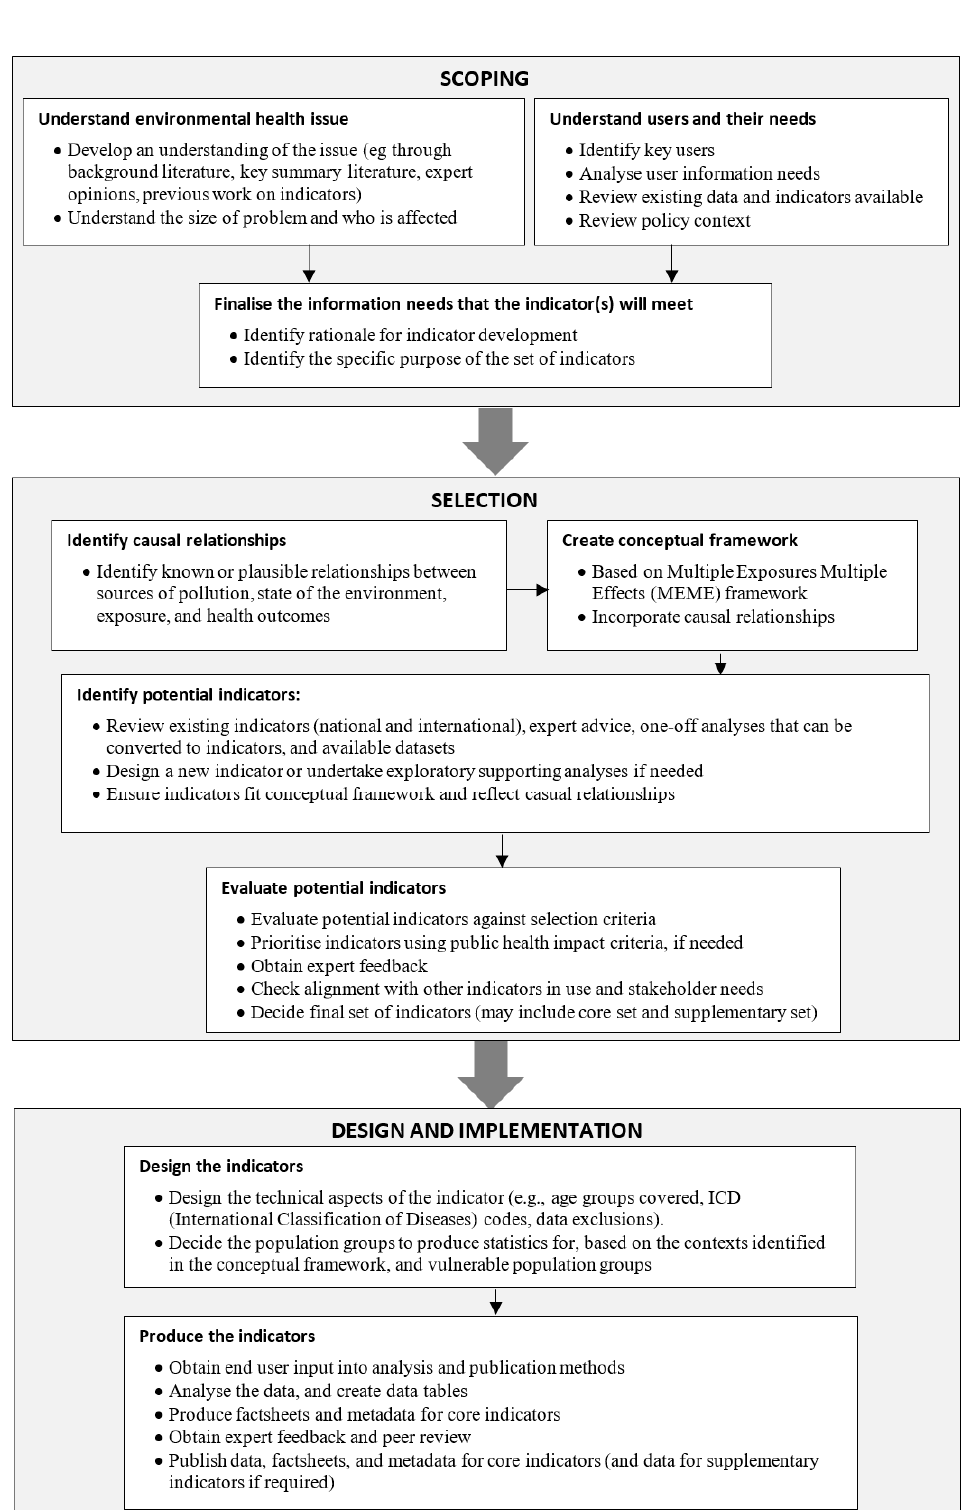
Figure 1. Process for developing a set of environmental health indicators. Source: Adapted from Briggs [2].